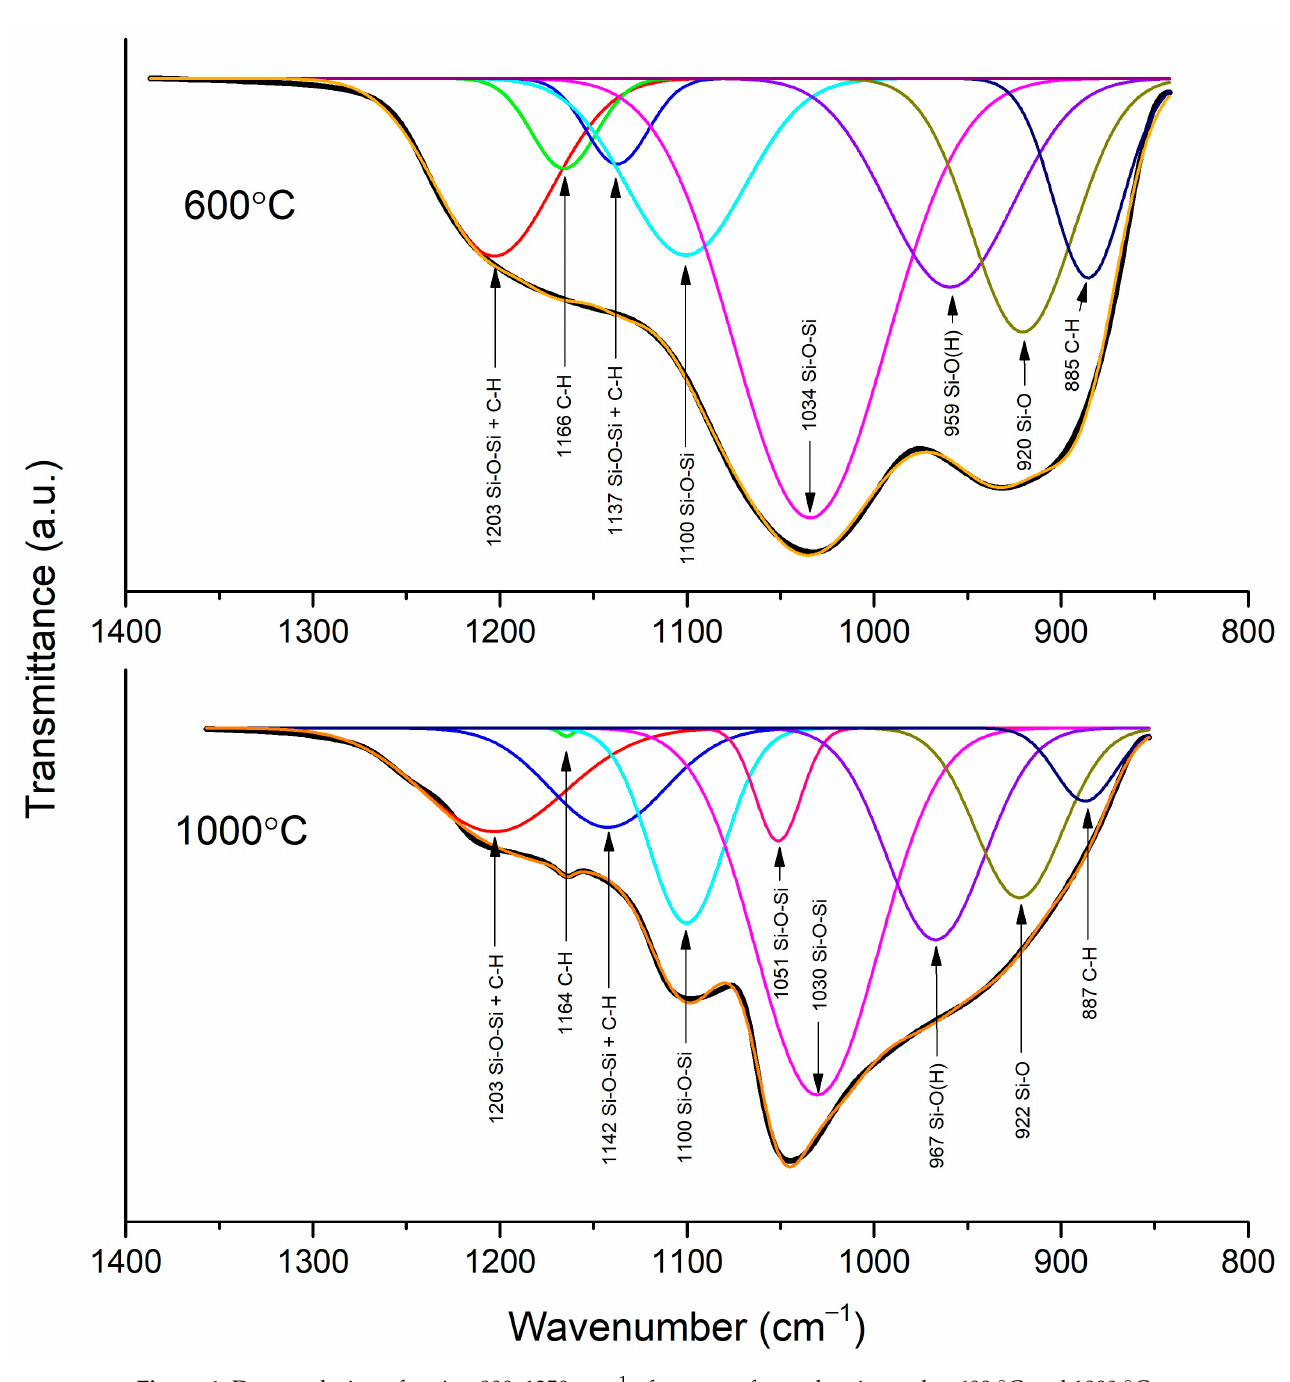
Figure 4. Deconvolution of region 800–1350 cm − 1 of spectra of samples sintered at 600 °C and 1000 °C.